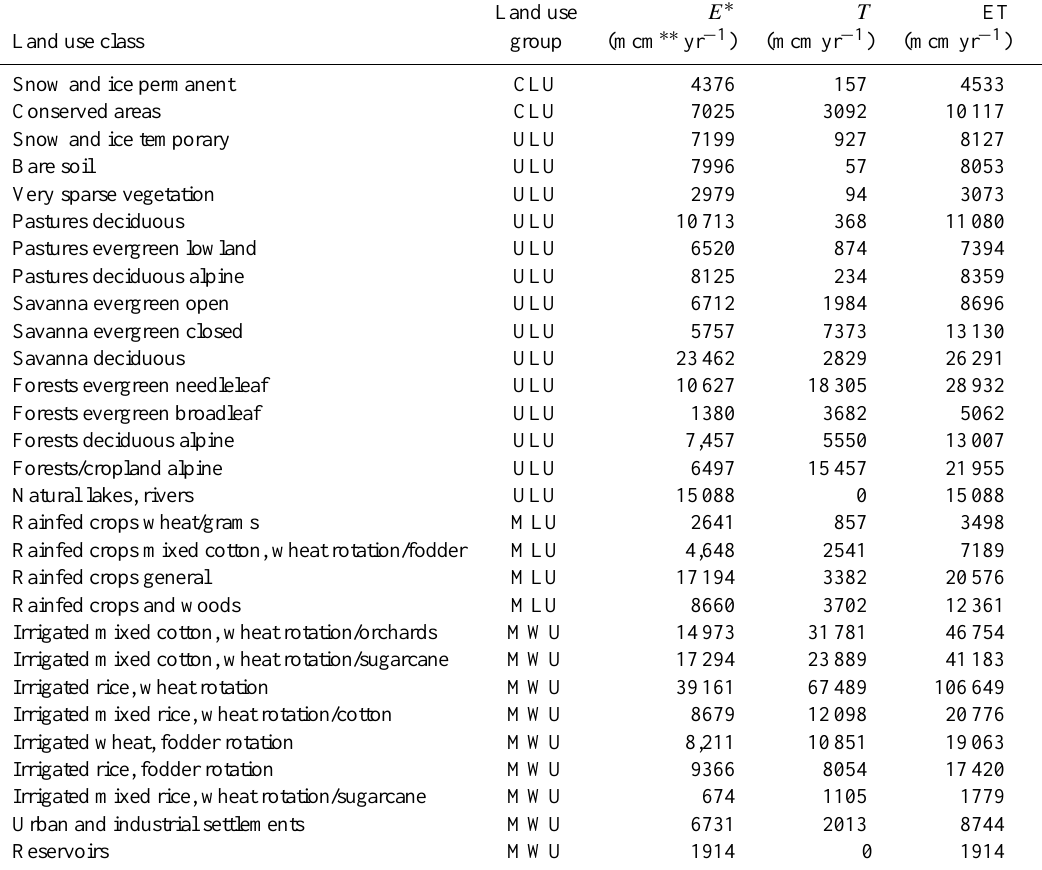
Table 2. Water depletion by LULC class in the Indus basin in